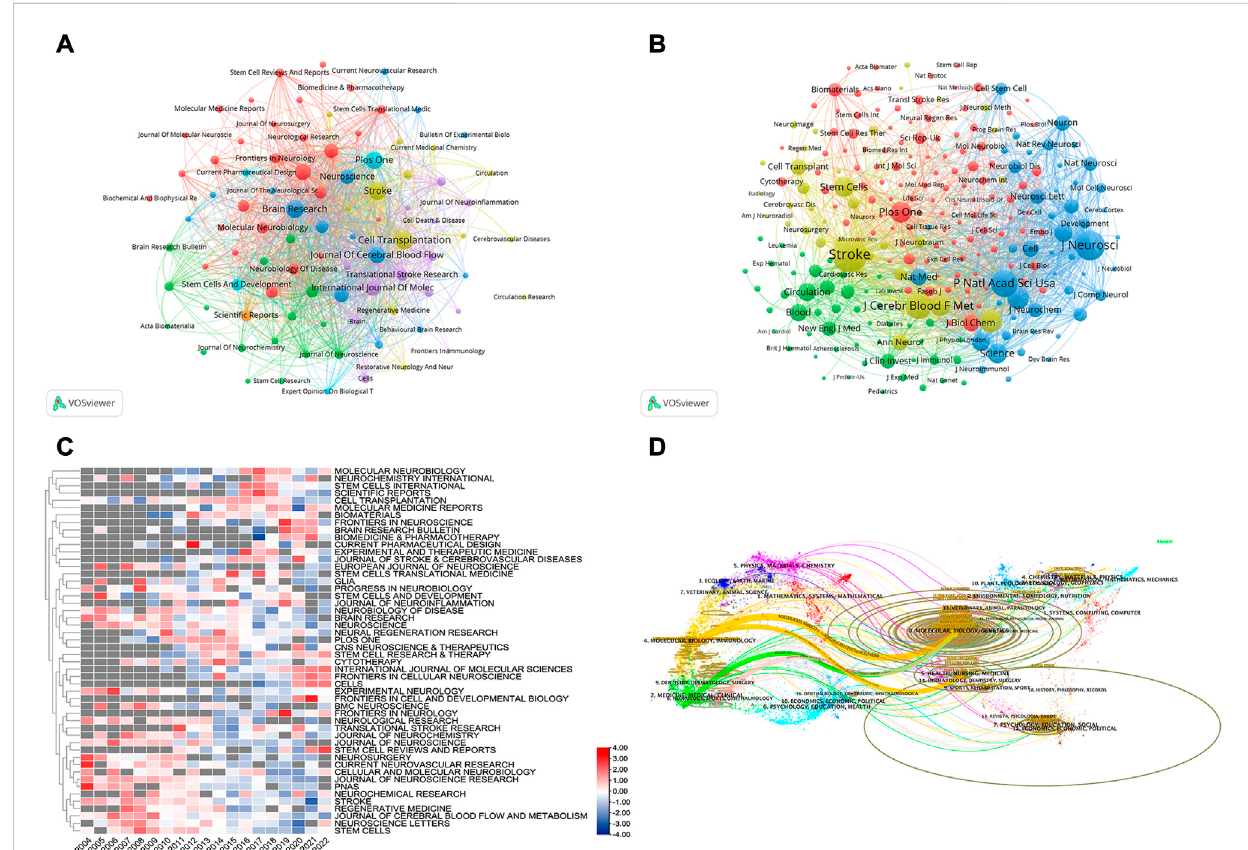
FIGURE 6 (A) Co-journal clustering analysis. Each circle represents a journal, the size of the circle depends on the strength of the connection, the number of citations, and so on. And, the color of the circle on behalf of the cluster to which it belongs, different clusters are represented by different colors. (B) Co- cited-journal clustering analysis (C) Journals heat map on stem cells in stroke. Each line was compared with each other. The value in the box is the number of articles published in the journal divided by the number of articles published in the year, verbalizing the current year ’ s popularity of the journal, The redder the color verbalizes the hotter journal in the year, so it was called the heat map (D) The dual-map overlay of journal publishing research. Citing journals on the left and cited journals on the right, and the curve is the citation line, which completely shows the context of the citation, the more papers the journal publishes, the longer the vertical axis of the ellipse; the more authors they are, the longer the horizontal axis of the